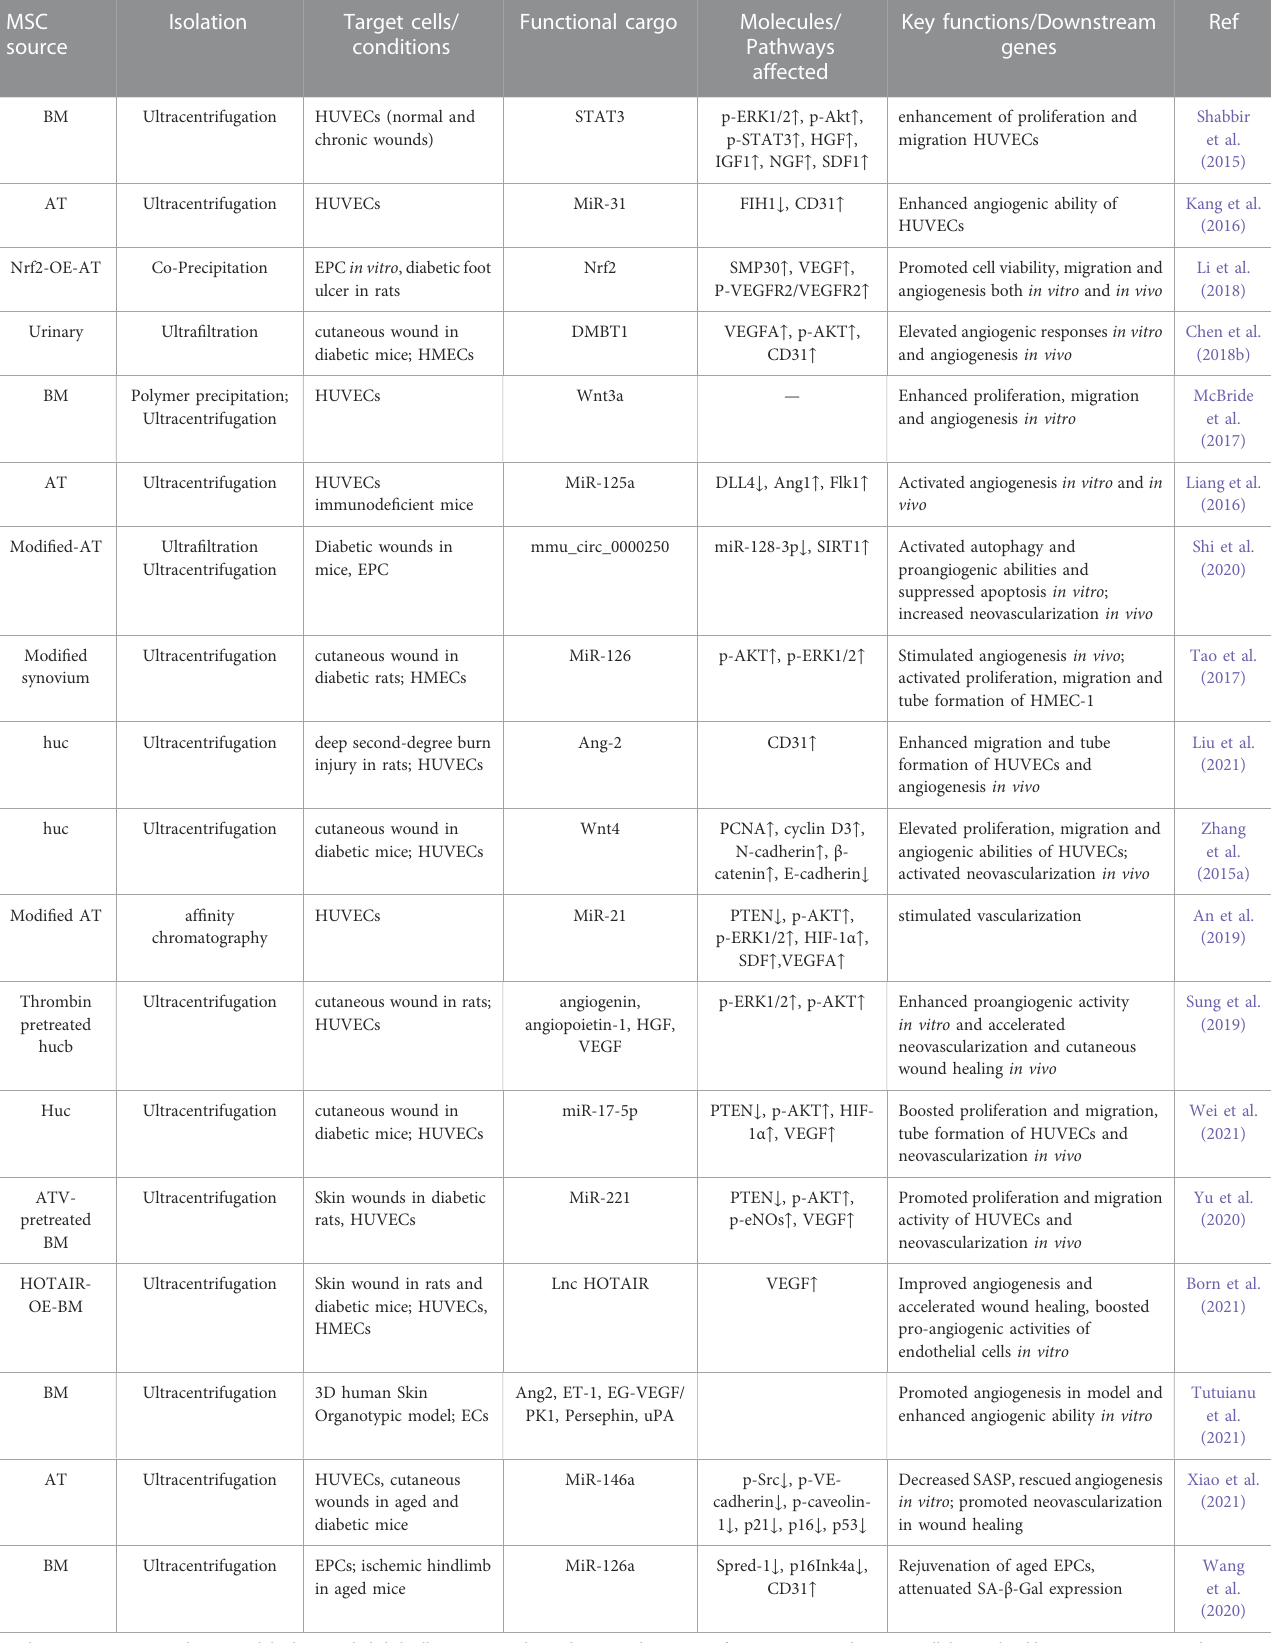
TABLE 4 MSC-sEVs stimulate angiogenesis by regulating vascular endothelial cells in wound